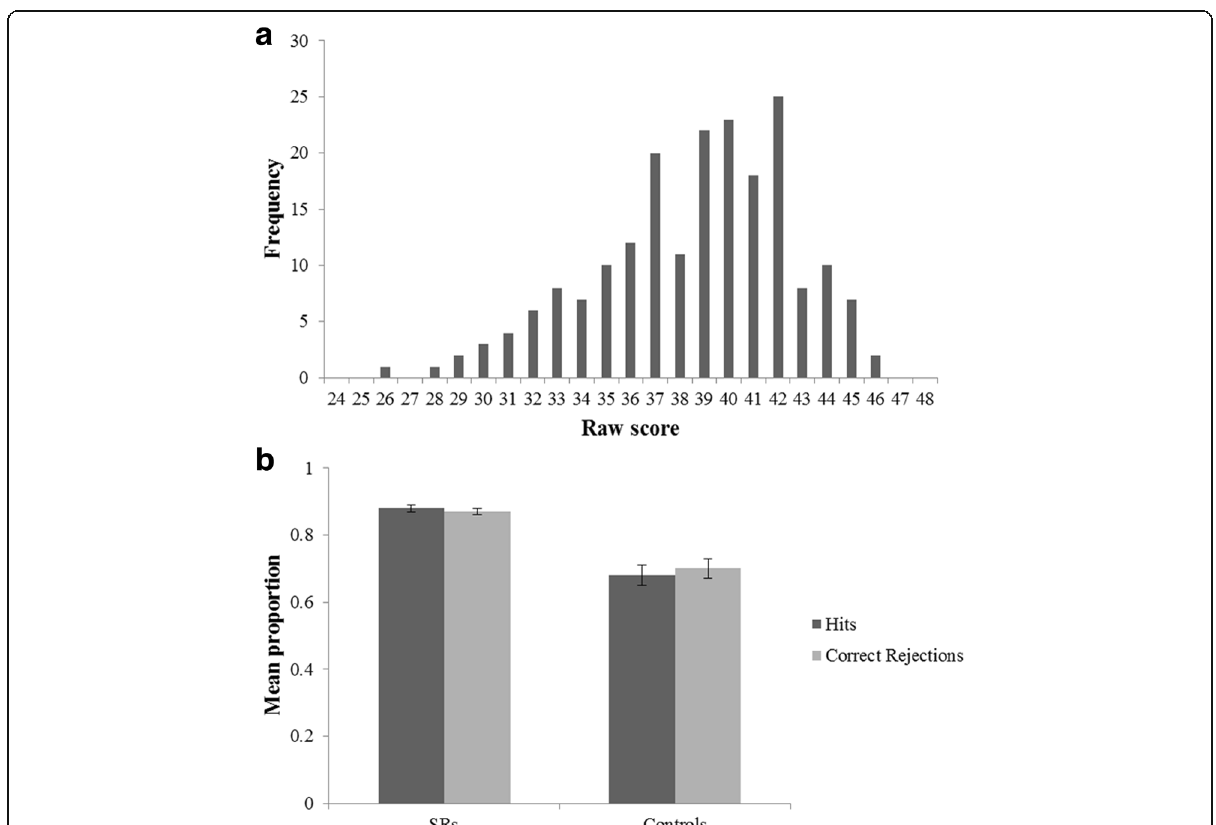
Fig. 5 Performance on the PMT. Distribution of experimental group ’ s performance on the PMT ( a ), and number of hits and correct rejections made by “ super recognisers ” (SRs) in comparison to controls ( b )